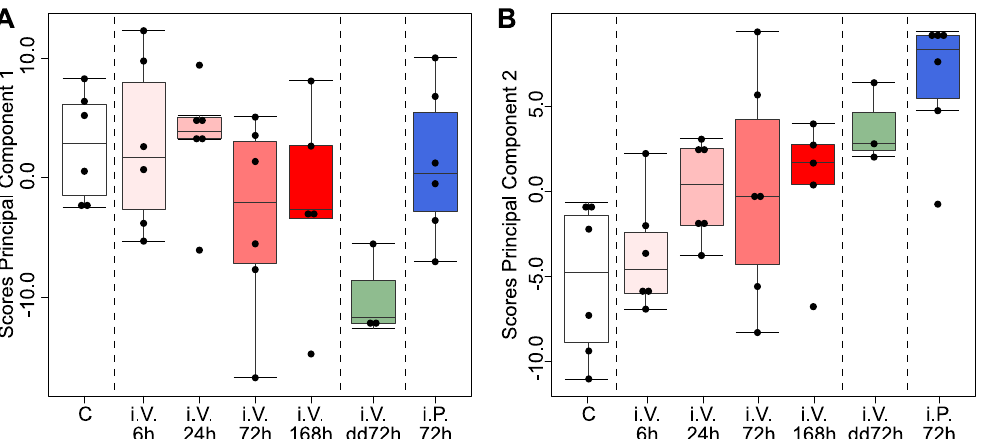
Figure 3. Scores of the principal component analysis of the lipidome in the jejunum. ( A ) Boxplots of the scores of the first principal component of the jejunal lipidome according to the treatment of the animals. ( B ) Boxplots of the scores of the second principal component of the jejunal lipidome according to the treatment of the animals. dd, double dose; i.V., intra venous treatment; i.P., intra peritoneal treatment.